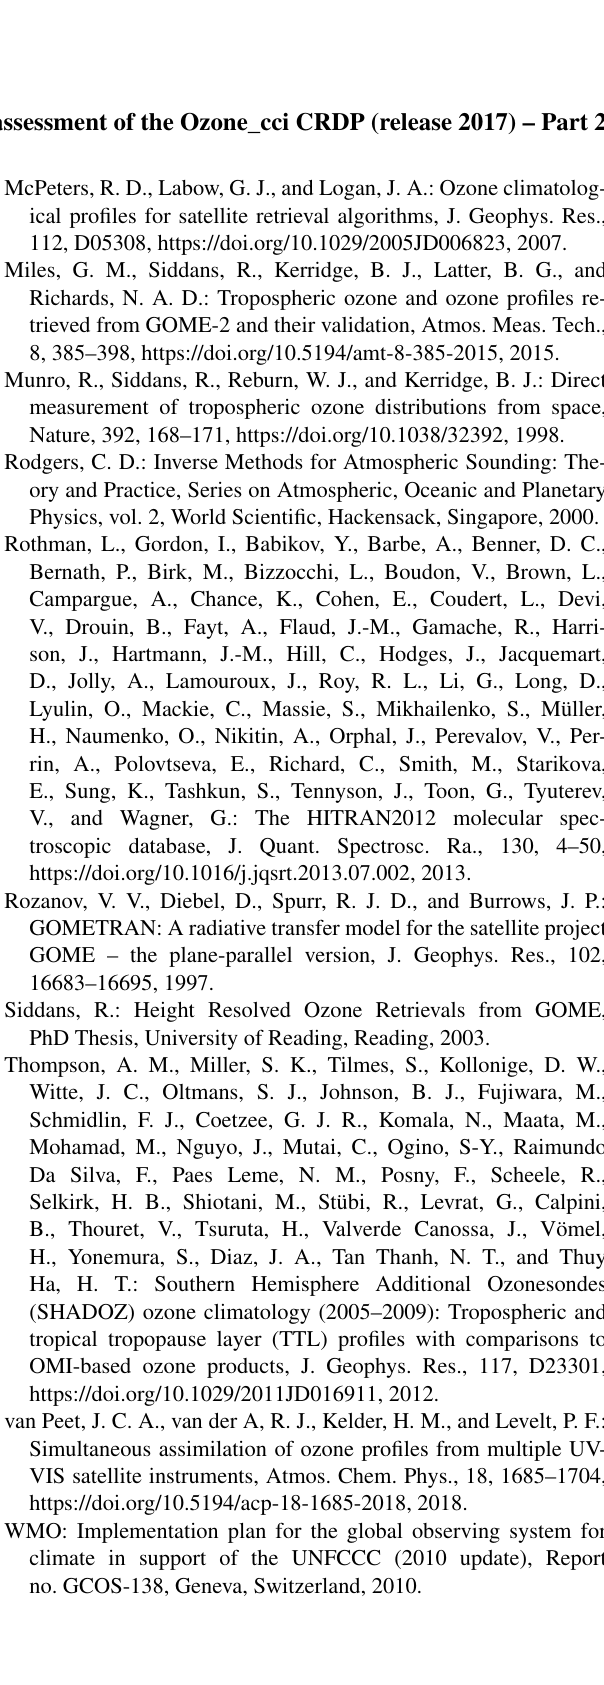
trometer (SBUV-TOMS) for Nimbus G, Opt. Eng., 14, 323–331,